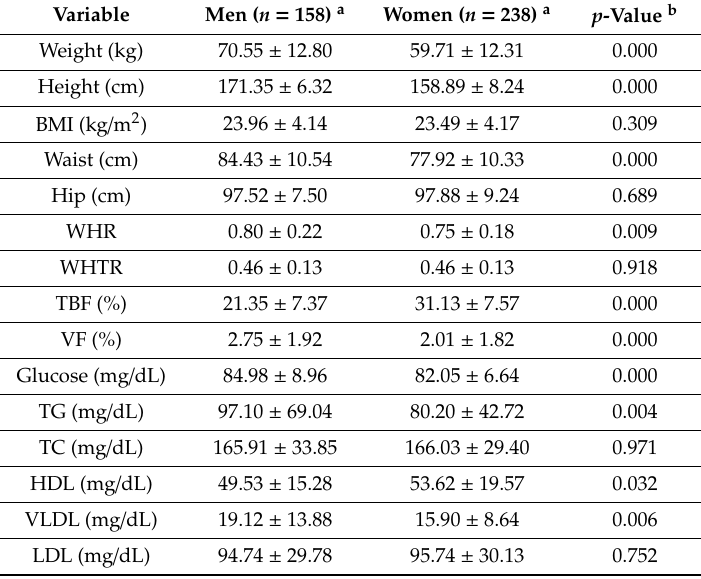
Table 2. The anthropometric and metabolic characteristics of the participants according to sex.